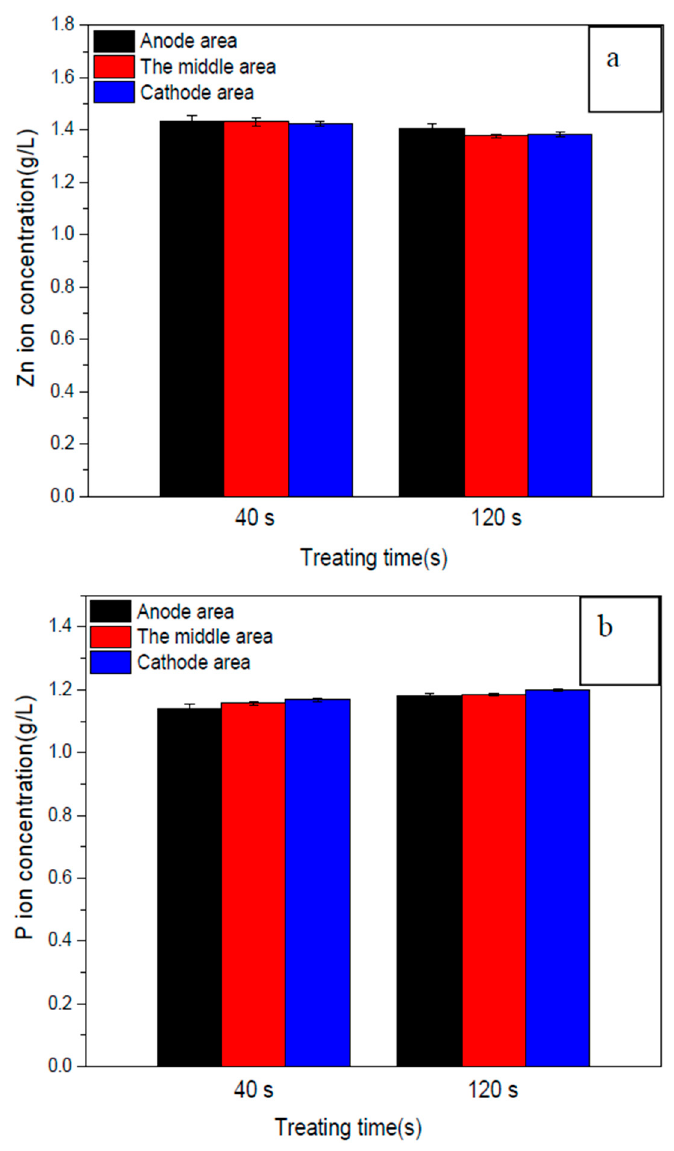
Figure 7. The concentrations of Zn and P in the solution containing 10 g/L EDTA-ZnNa 2 , 2 g/L KOH and 8 g/L phytic acid in anode area, the middle area and cathode area during MAO treatment for 40 s and 120 s.